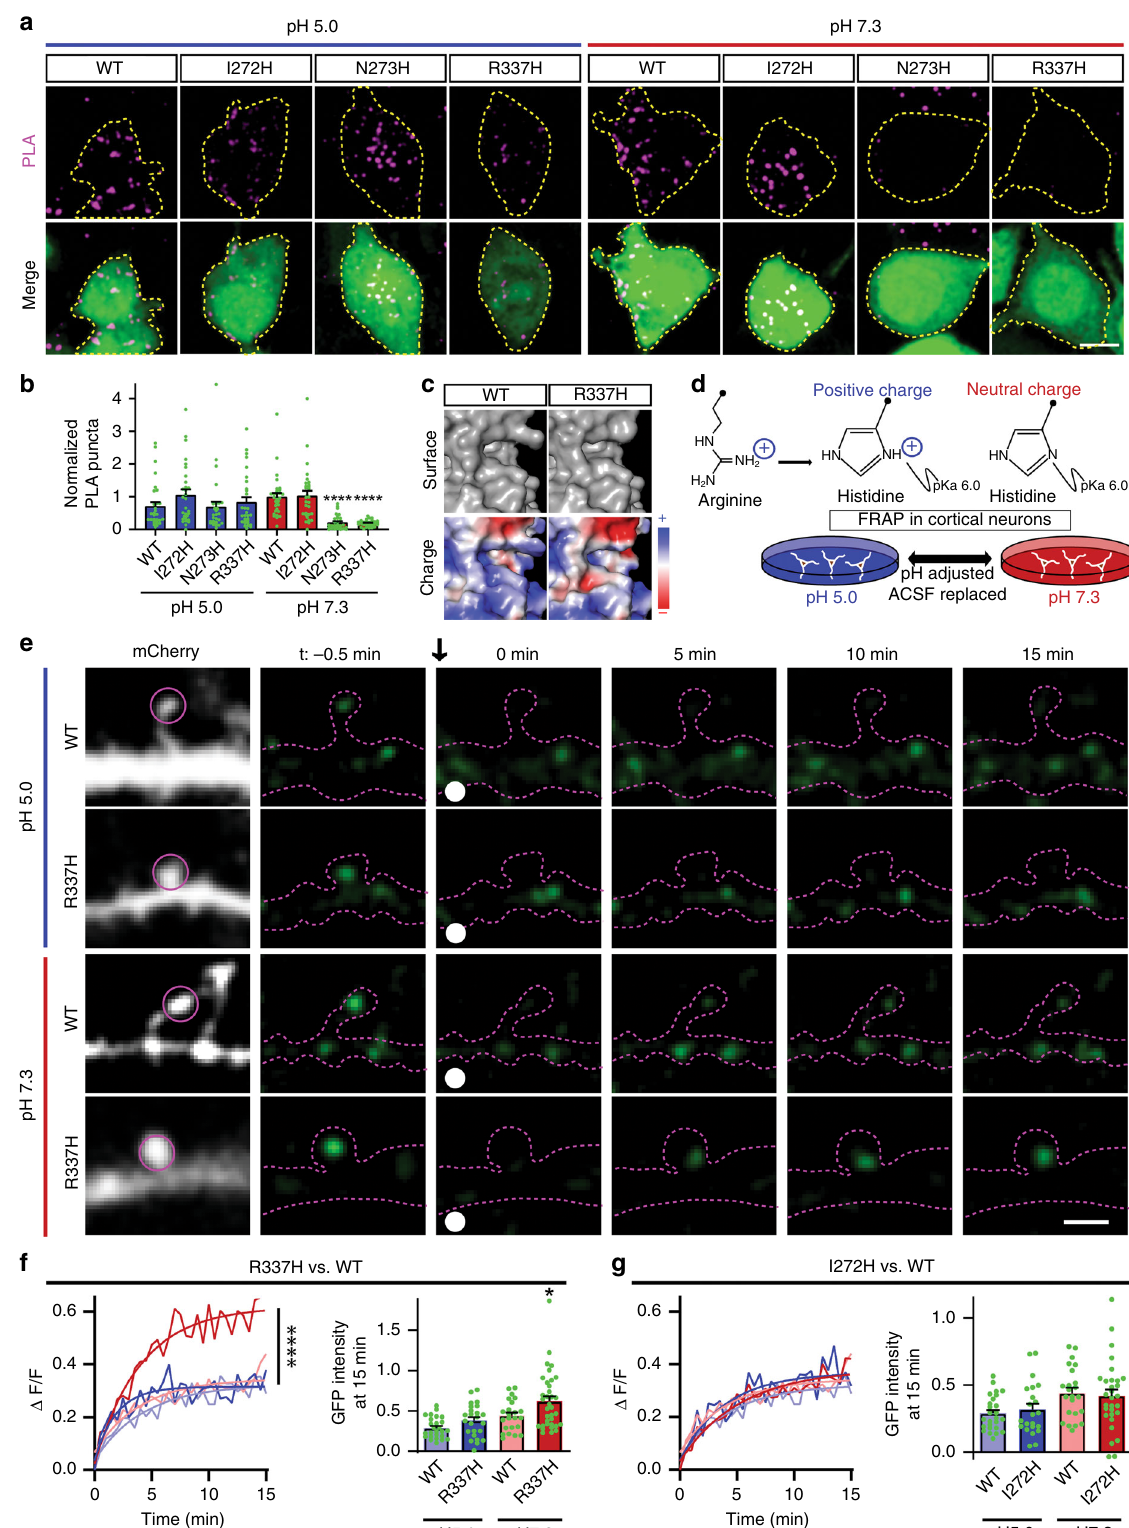
HEK293T cells were placed in either pH 5.0 (H-positive) or pH 7.3 (H-neutral) cell culture media for 20 min and then fi xed. All GluN1 mutants expressed and were found at the surface at similar or higher levels compared to WT GluN1 in HEK293T cells at both pH 5.0 and pH 7.3 (Supplementary Fig. 10a – c). PLA was